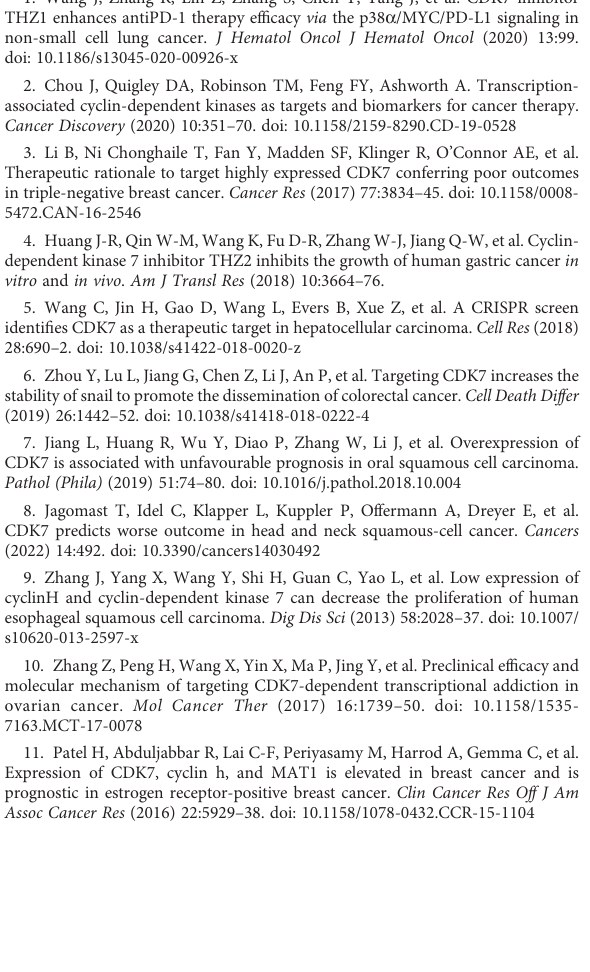
SUPPLEMENTARY FIGURE 1 Exemplary TMA core of a CDK7 stained sqNSCLC segmented automatically by QuPath (tumor cells are annotated with yellow/orange depending on chromogenic intensity, immune cells are annotated with purple/blue, stroma with green, pigment with black). Tumor cells were de fi ned as regions of